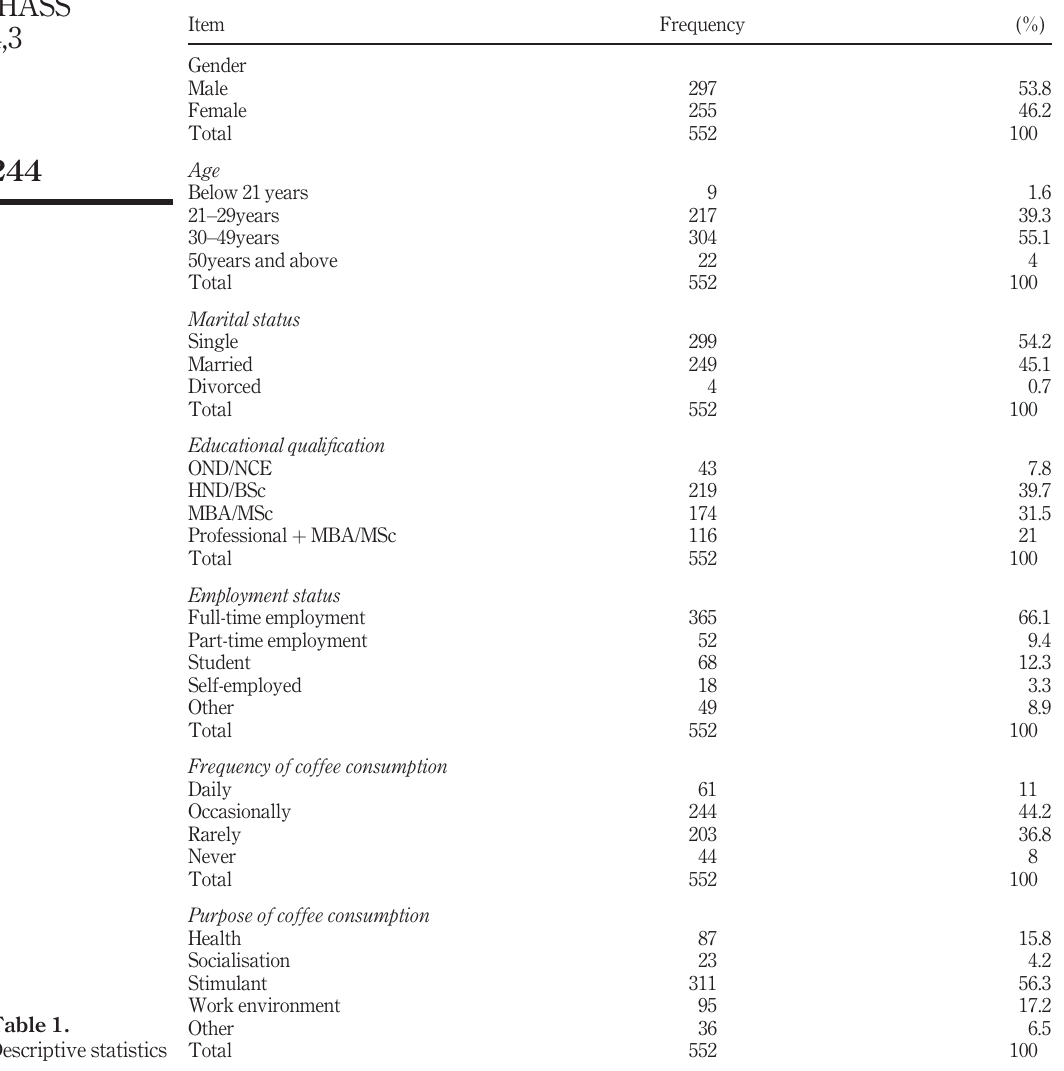
Presentation of data fi ndings. A total of 552 data responses were analysed using SPSS 25 software. The distribution of the study respondents is shown in Table 1. In terms of gender, most of our respondents are males (53.8%). In terms of age, most of our respondents are between 30 and 49years (55.1%). In terms of marital status, most of our respondents are single (54.2%). In terms of educational quali fi cation, most of our respondents are HND/BSc holders (39.7%). In terms of employment status, most of our respondents are fully